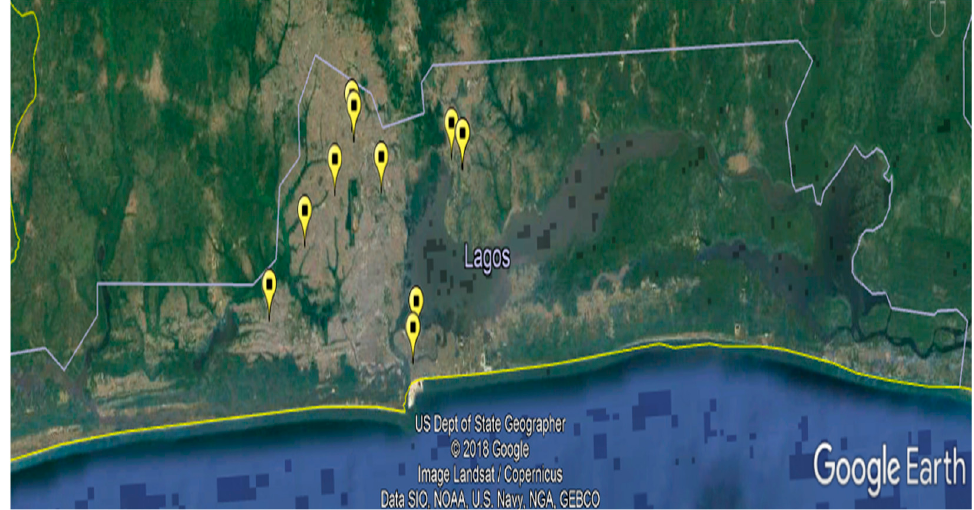
Figure 1. The map of Lagos State, Nigeria showing the locations of the public and private owned veterinary clinics and hospitals involved in the study.